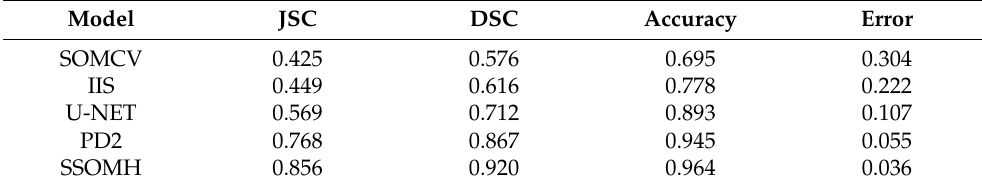
Figure 5. Segmentation Results of Four Samples of Test Images (CBIS-DDSM Database) for the SOMCV, IIS, U-NET, PD2, SSOM and SSOMH Models. Table 3. Average Values of JSC, DSC, Accuracy and Error for All